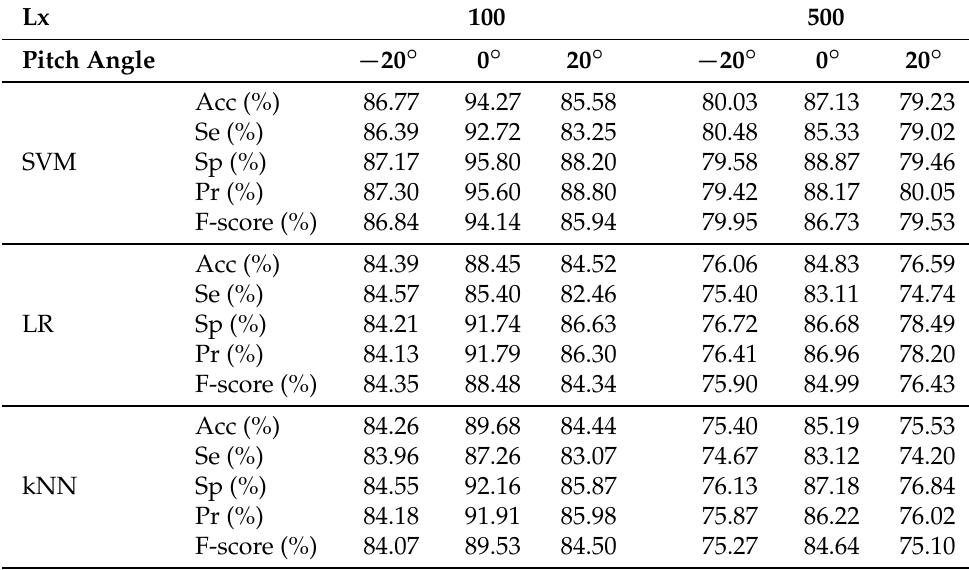
Table 5. Facial expression classification results obtained at varying of three different classifiers (SVM, LR and kNN), two lighting conditions and three pitch